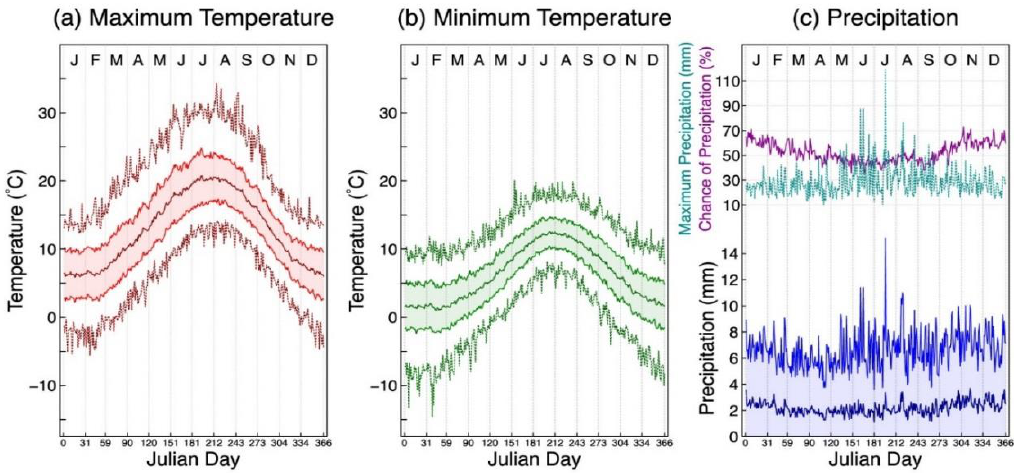
Figure 2. ( a , b ) The 1883–2015 daily mean TX/TN (main bold line). Shaded regions indicate ±1 standard deviation and outlying lines indicate the record maximum/minimum daily value. ( c ) The lower plot indicates the daily mean (bold line) and standard deviation (shaded region) of precipitation. The upper axis illustrates the daily maximum recorded precipitation value and the daily likelihood of precipitation (same scale, but units of mm for maximum precipitation and per cent for precipitation